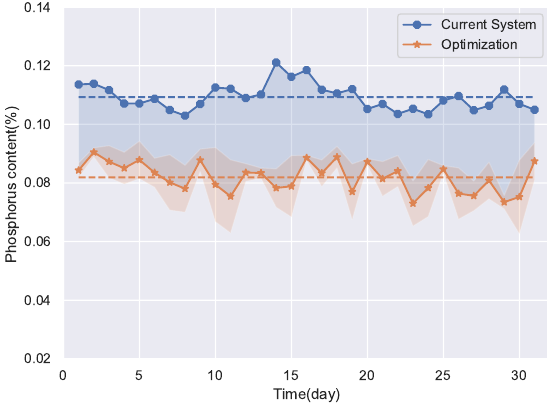
Figure 15. Optimization results of the proposed